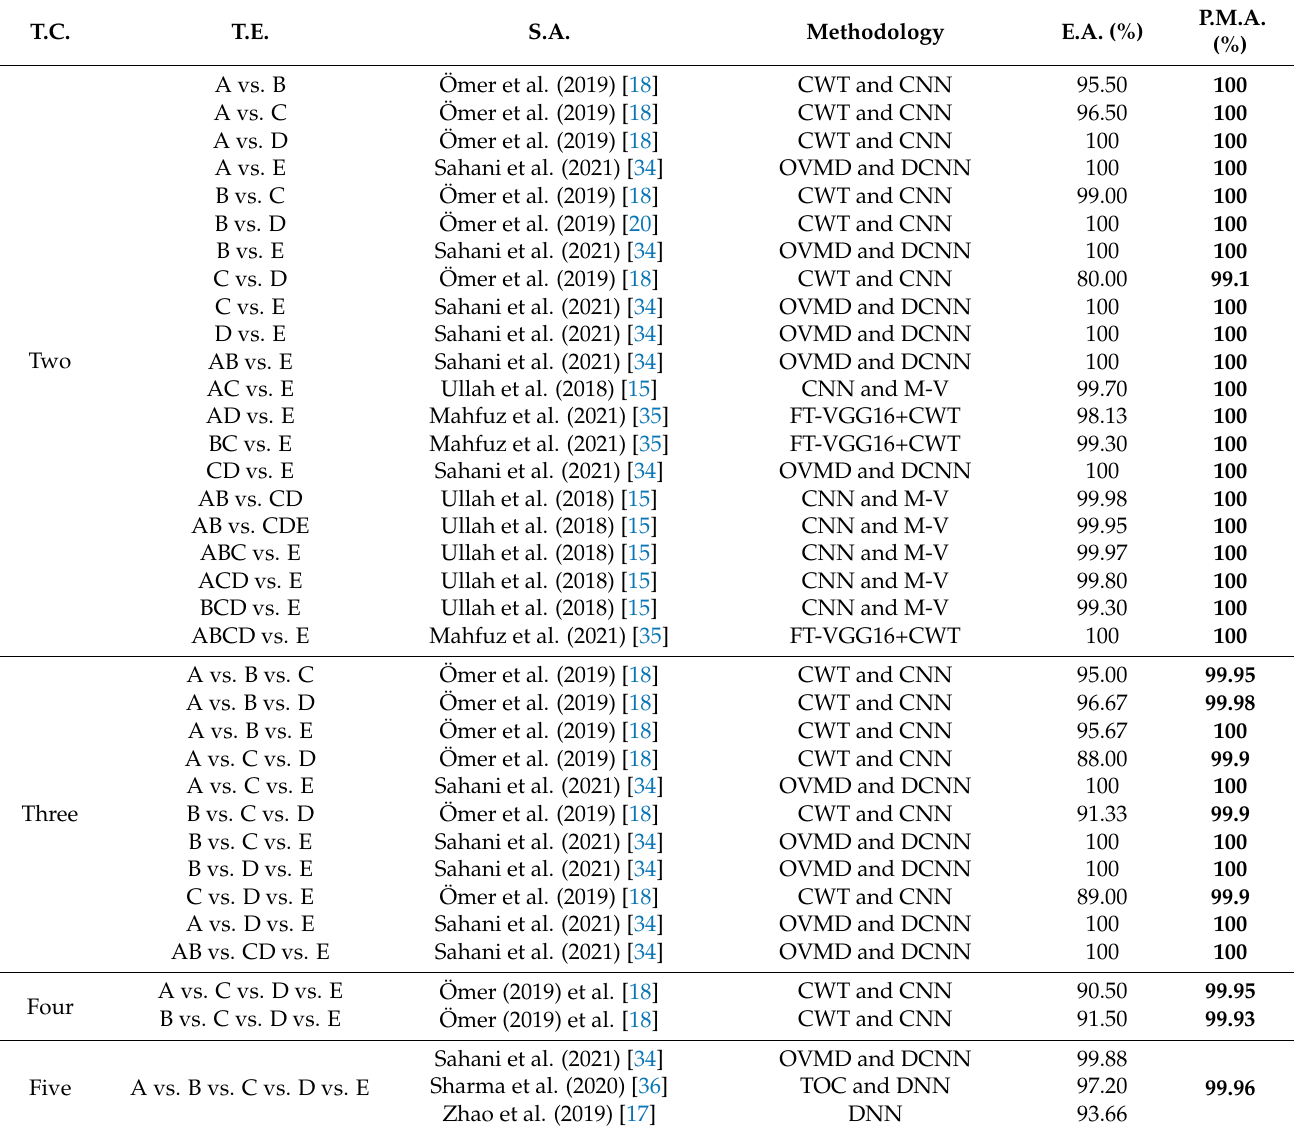
Table 8. Summary of the previous studies and comparative accuracy of the proposed method with the existing methods on the same